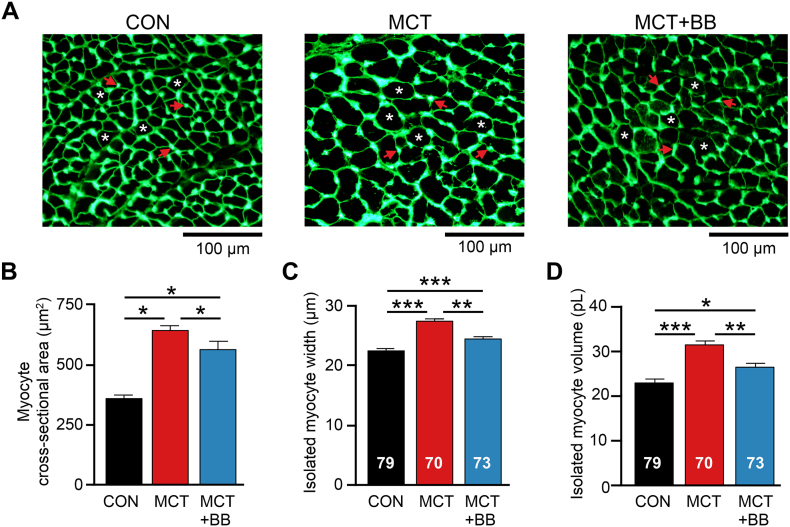
BB attenuated RV myocyte hypertrophy. A Exemplar images of RV cryosections stained with lectin to fluorescently label the membrane of myocytes. Capillaries are also stained by lectin and appear as dense spots of labelling. A selection of myocytes (asterisks) and capillaries (arrows) are indicated. B Mean myocyte cross sectional area was greater in MCT compared to CON and MCT + BB. The mean value of 2–5 RV sections from each heart were used for statistical analysis. Data represents means from N = 6 rats per group. C The cell width and D cell volume of isolated myocytes was greater in MCT than CON and MCT + BB. B N = 6 rats per group, C,D N = 6–9 rats per group, myocyte numbers given in the figure. One-way ANOVA. *P < .05, **P < .01, ***P < .001.